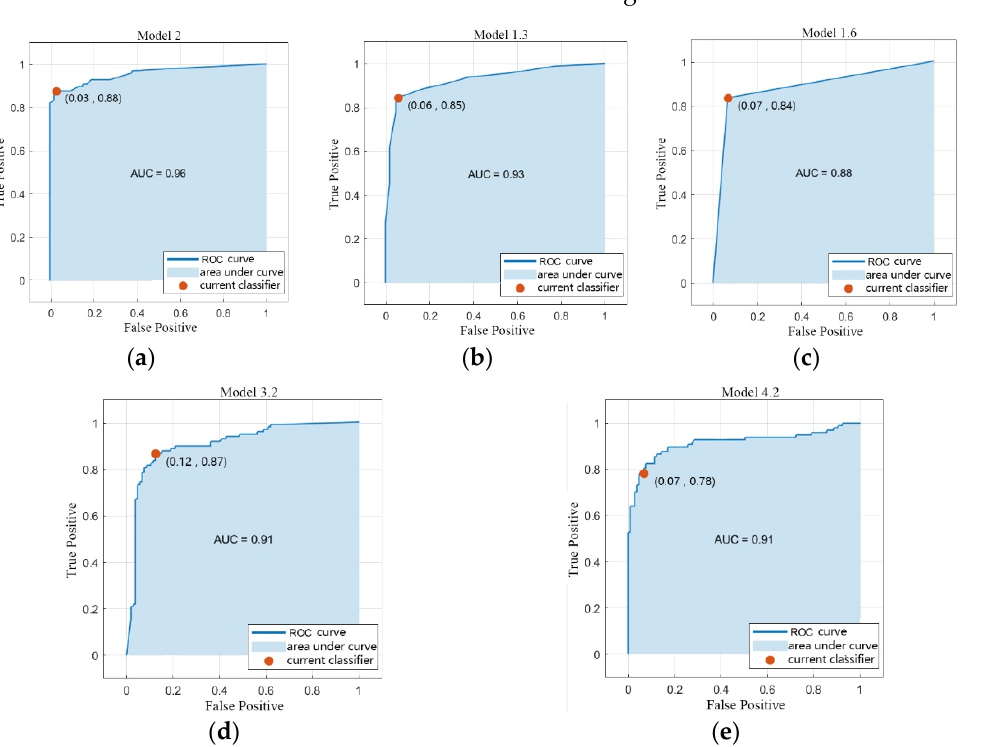
Tree ( c ) KNN ( d ) Naive Bayesian ( e ) SVM.